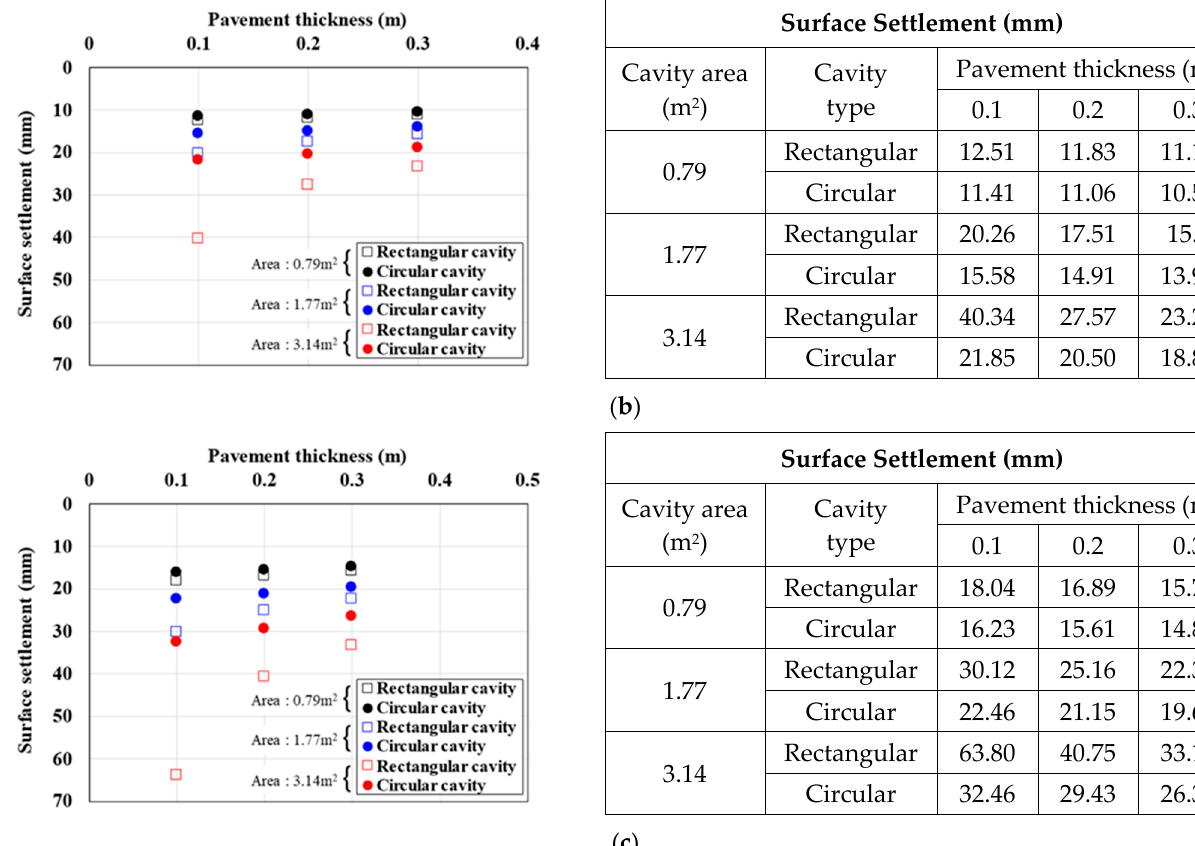
Figure 12. Surface settlement according to pavement thickness by cavity area (pavement elastic modulus: 500 MPa). Traffic load: ( a ) 12.7, ( b ) 25.4, and ( c ) 38.1.